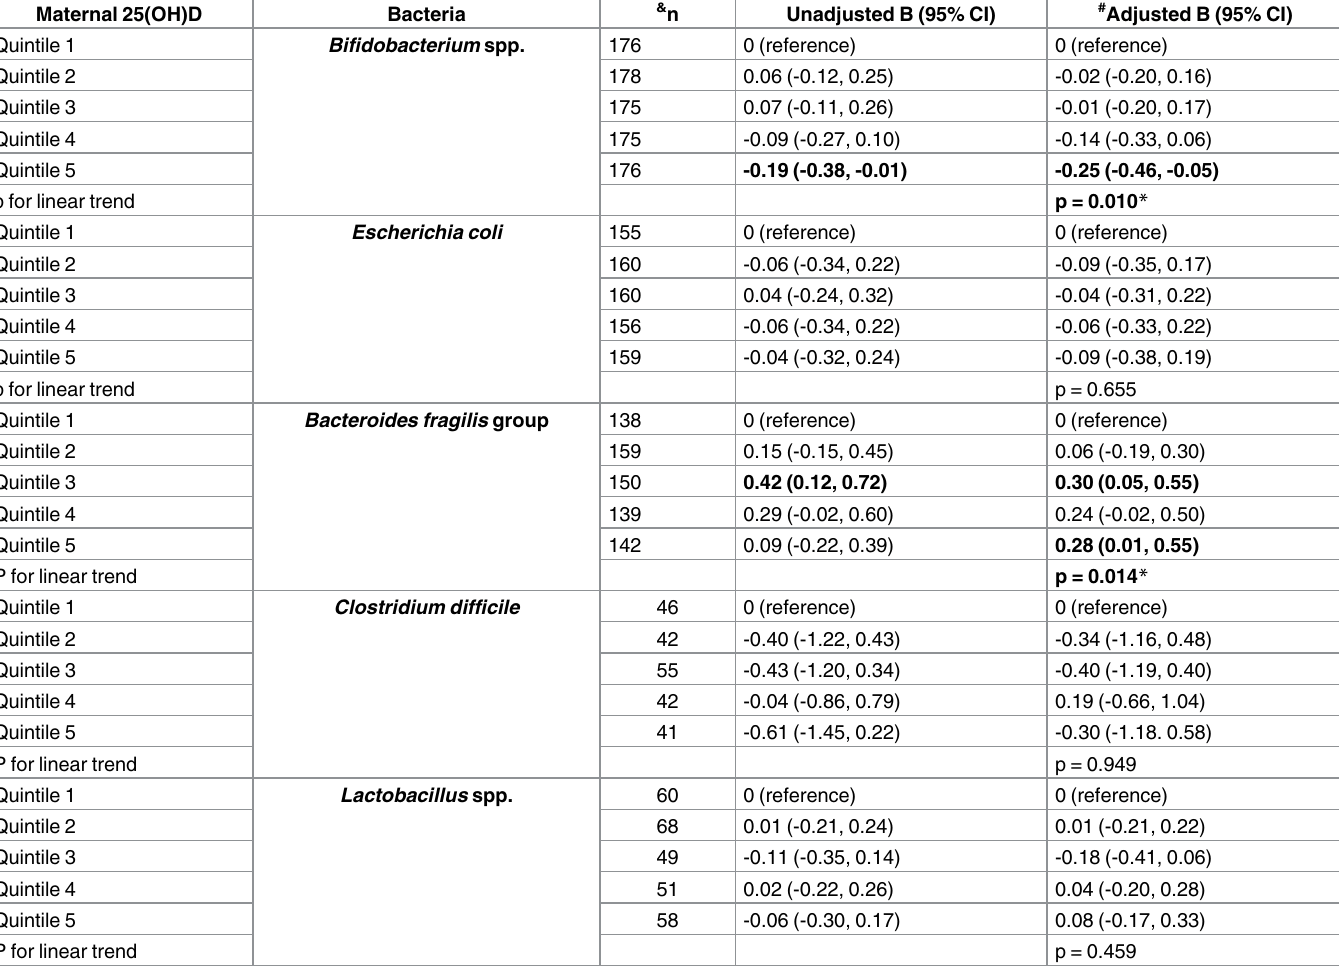
Table 4. Association between maternal 25(OH)D levels during pregnancy and log 10 colony forming units of bacterial species or groups in infants colonized with the respective